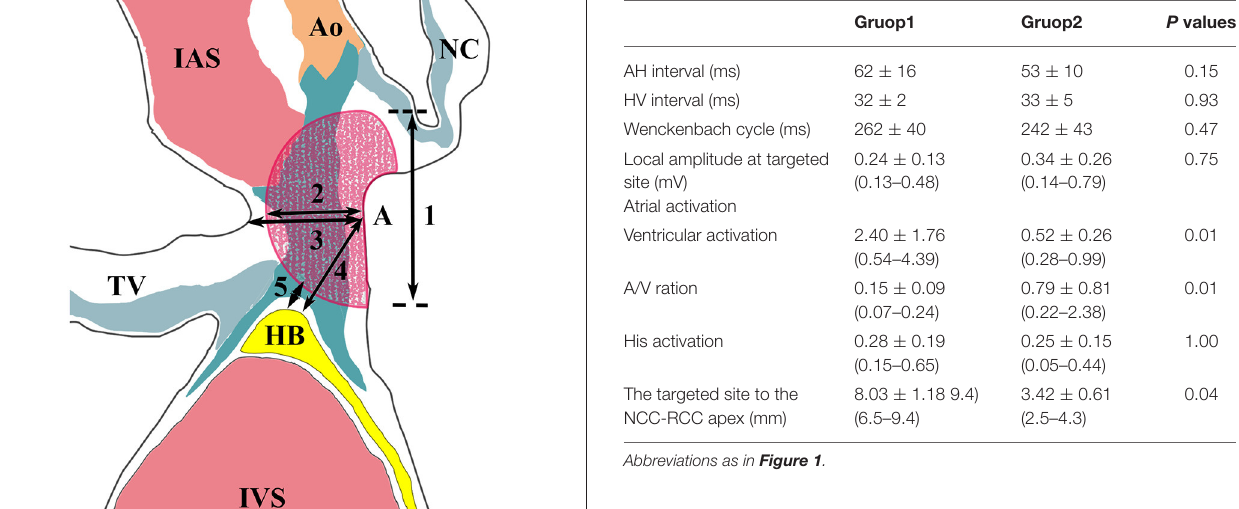
TABLE 1 | Eletrophysiologic study, mapping, and ablation